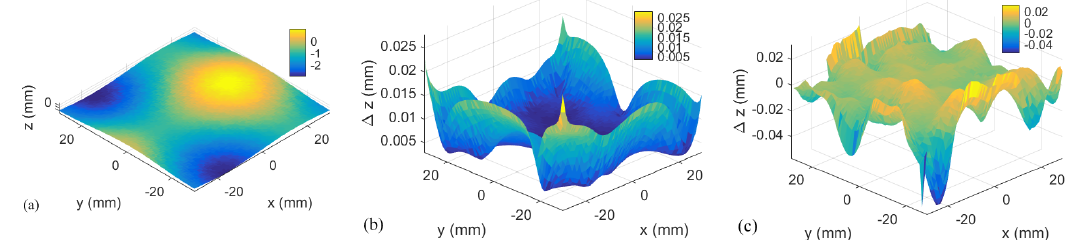
Figure 21. Mean surface, associated uncertainty and deviation from the reference data after data fusion: ( a ) mean surface; ( b ) associated uncertainty; and ( c ) deviation from the reference data. Appl. Sci. 2016 , 6 , 409